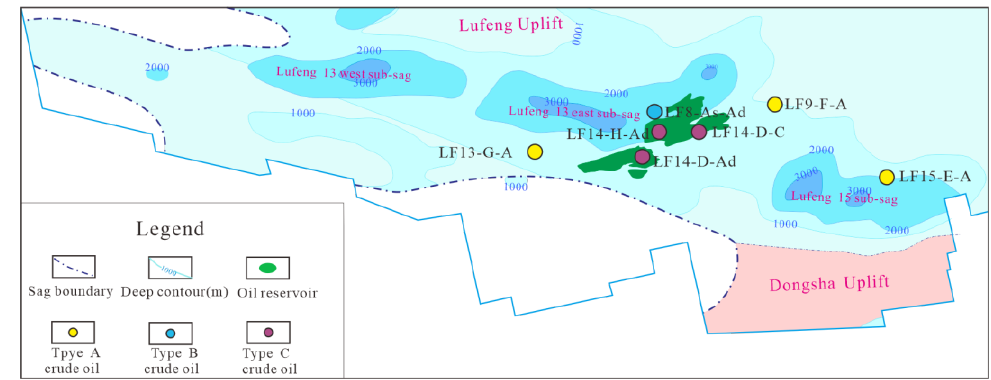
Figure 9. Oil and source rock correlation results for the WC in the southern Lufeng sag.